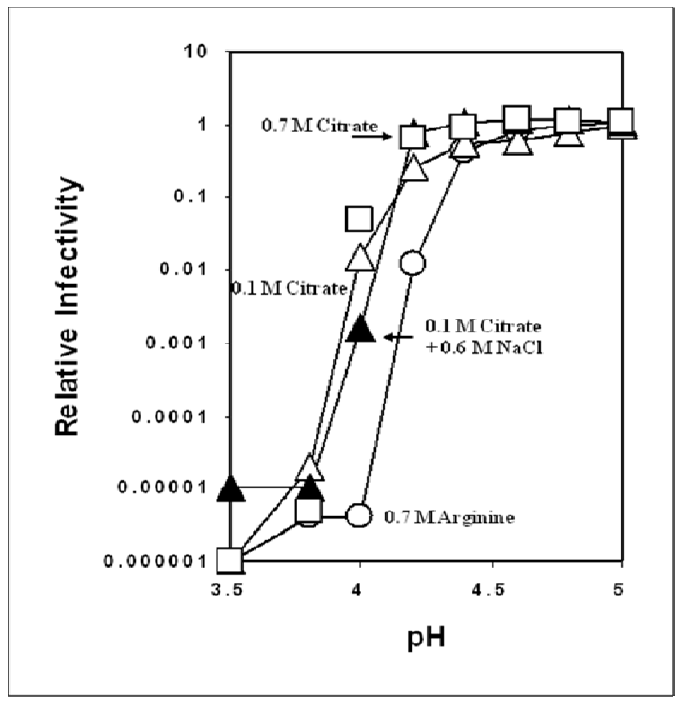
HSV-2 was incubated with the indicated solvents at 20 °C for 5 min. The surviving virus